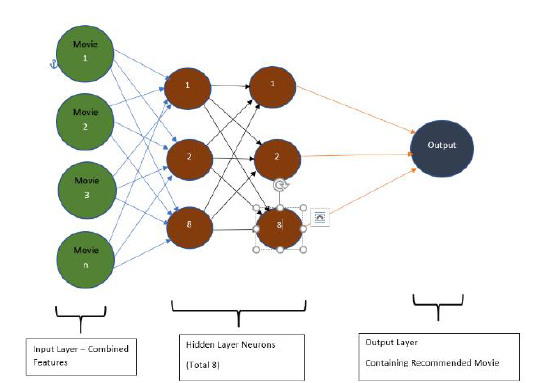
Fig 2. Neural Network